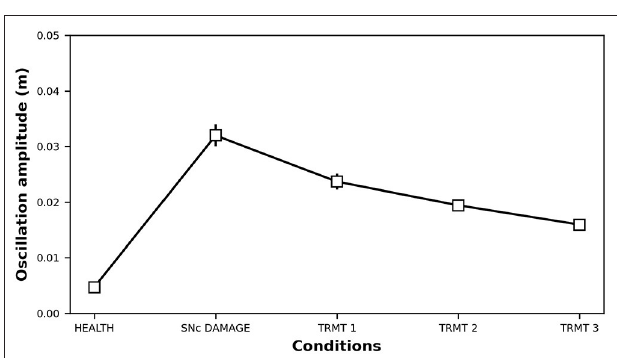
FIGURE 7 | Oscillation amplitude of the bio-mimetic arm before and after the DA impairment ( τ SNc + 70 % , α IP + 333 % ) and following SSRIs